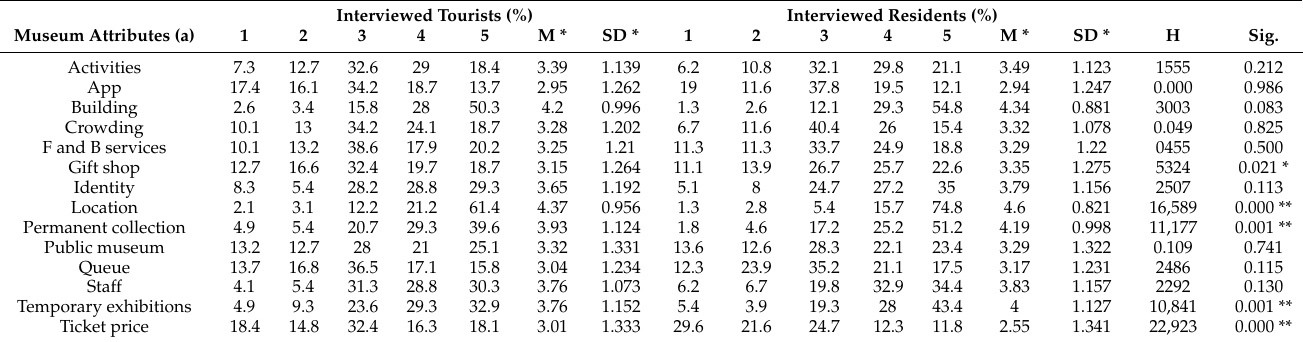
Table 5. Level of importance of museum attributes based on quality and value perceived by interviewed tourists and interviewed residents: Kruskal–Wallis